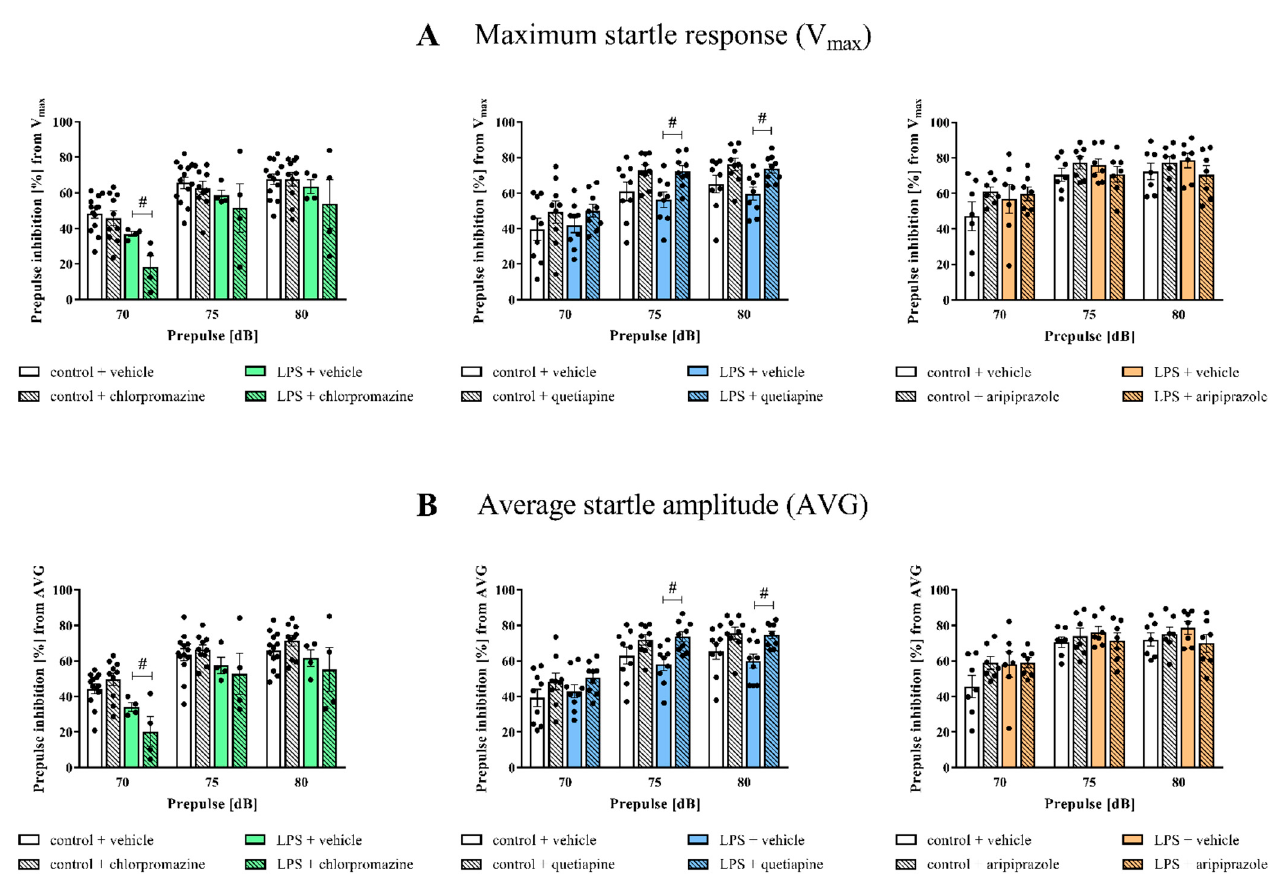
Figure 2. The impact of 14-day intraperitoneal administration of chlorpromazine, quetiapine or aripiprazole on the prepulse inhibition (PPI) of the acoustic startle response in the control and prenatally LPS-exposed offspring in adulthood. The numbers of animals in the cohorts were as follows: n = 4–13 (chlorpromazine), n = 9 (quetiapine) and n = 7 (aripiprazole) in each group. The results are presented as the means of the percentage of PPI (%PPI) calculated from the maximum startle response (V max ) ( A ) and average startle amplitude (AVG) ( B ) induced by each prepulse intensity ± SEM. # p < 0.05 vs. LPS + vehicle group.